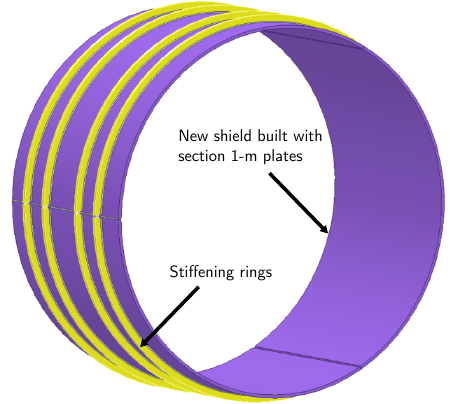
Figure 5. Alternative 2: Self-supporting lining with multi-section